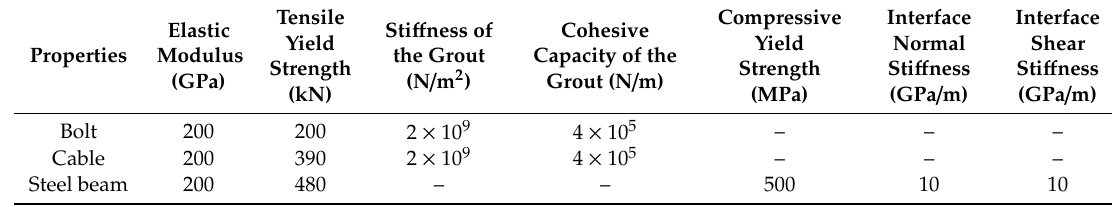
Table 6. Properties of support elements used in the UDEC